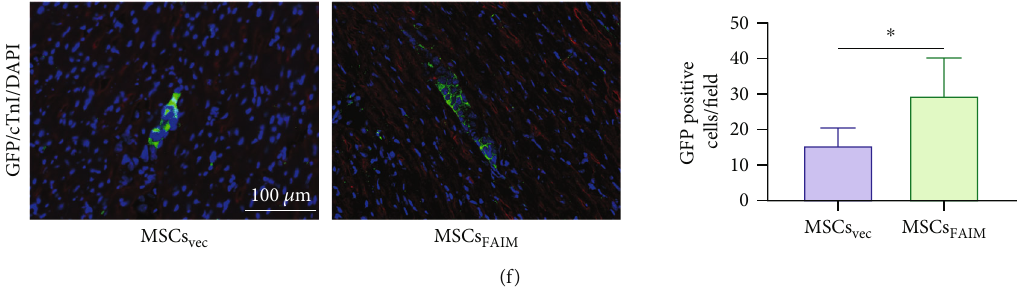
Figure 1: FAIM protected MSCs against apoptosis in vitro and in vivo. (a) MSCs were cultured for 12h under OGD conditions or normoxic conditions, and the mRNA level of FAIM was determined by qPCR and normalized to GAPDH. (b) Immunoblot analysis and densitometric quanti fi cation of FAIM protein levels under OGD conditions or normoxic conditions. GAPDH served as a loading control. (c) Annexin V- APC/PI staining was performed, and fl ow cytometry was used to determine the apoptosis rate. The apoptosis rate was calculated as the sum of the percentages of Annexin V + /PI - cells and Annexin V + /PI + cells. (d) TUNEL staining after FAIM overexpression followed by OGD stimulation for 12 h ( scale bar = 100 μ m ). Quantitative results are shown on the right. Six visual fi elds were randomly chosen for each well; the apoptotic index was determined as the percentage of TUNEL-positive nuclei. (e) Cleaved caspase 3 protein expression after FAIM overexpression or vector infection followed by OGD stimulation. The results of densitometric quantitation are shown on the right. (f) Representative images showing GFP immuno fl uorescence (IF) staining 3 days after LAD ligation followed by MSC transplantation. GFP appears in green, cardiac troponin I (cTnI) in red, and nuclei in blue. ( scalebar = 100 μ m ). Quantitative results are shown on the group and MSCs group). Data are shown as the mean ± SD . ∗ denotes P < 0 : 05 , ∗∗ P < 0 : 01 right ( n = 6 for the MSCs Vec FAIM